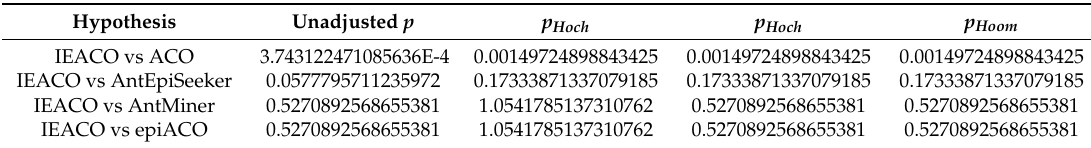
Table 5. Adjusted p -values on 500-SNP datasets.